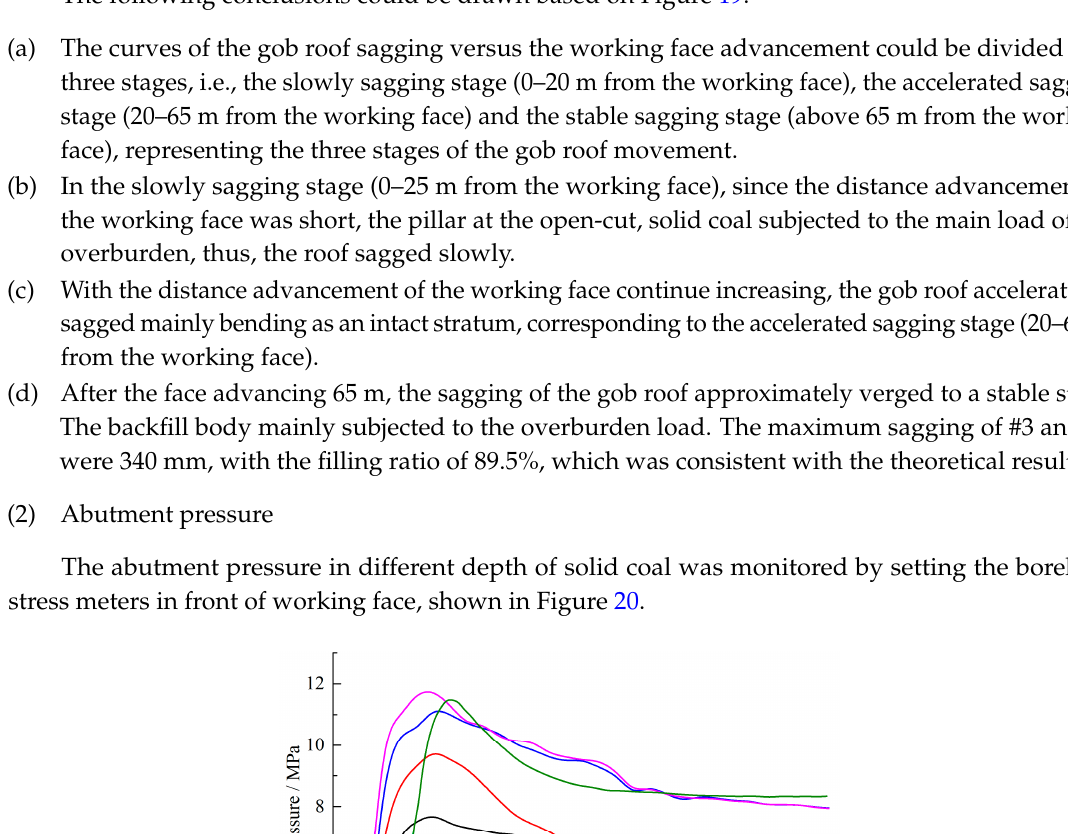
Figure 19. The sagging curves of the gob roof versus advancement distance of the working face.